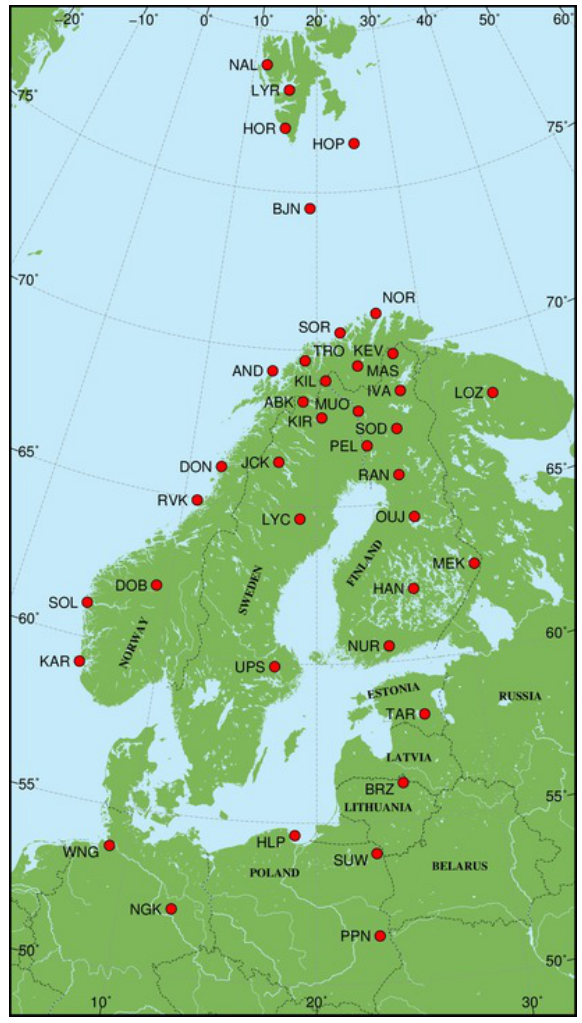
Figure 1. IMAGE station locations and name abbreviations in 2017 (IMAGE,